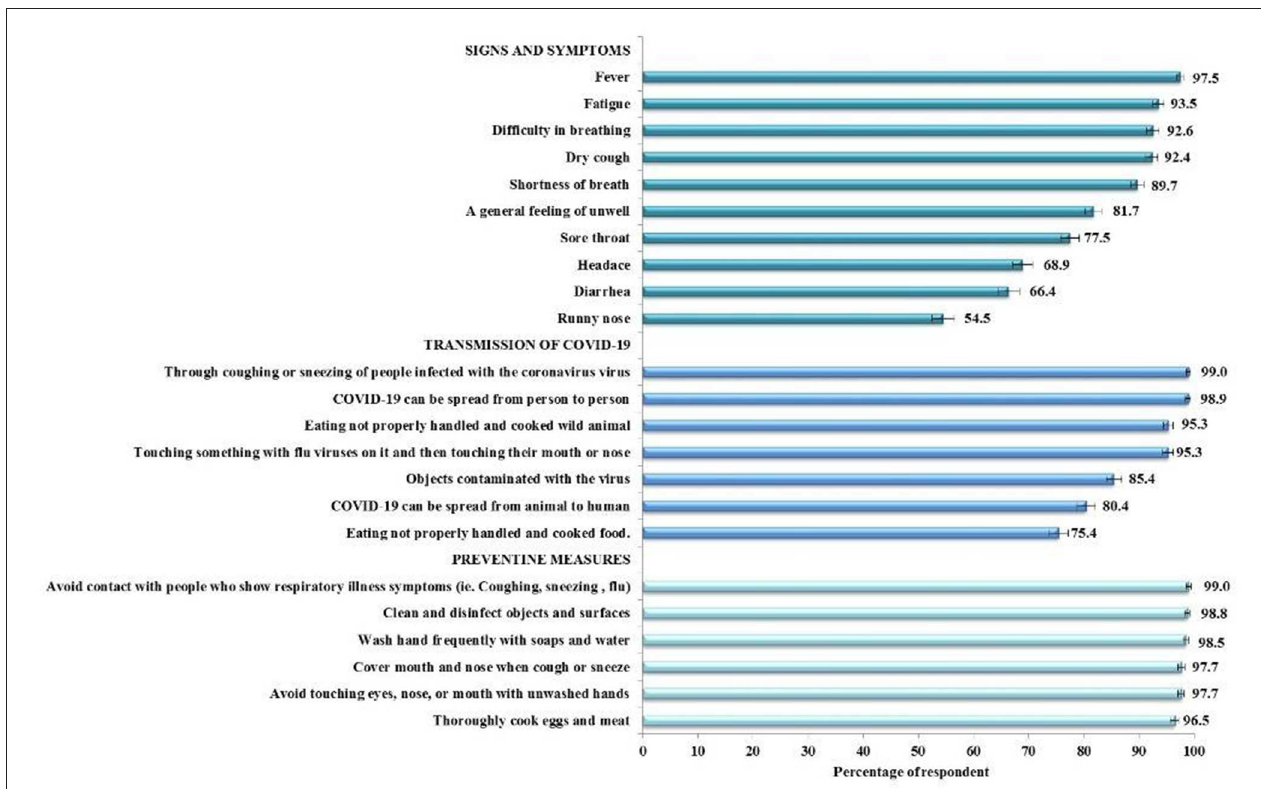
FIGURE 1 | Percentages of correct responses to knowledge items ( N =